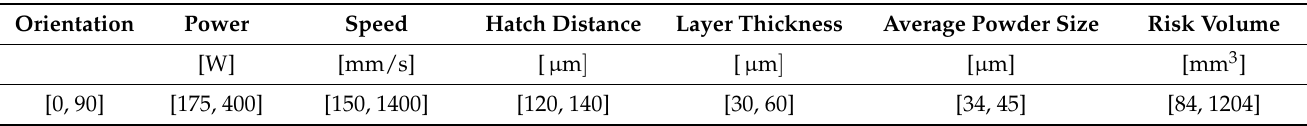
Table 2. Range of process parameters for the datasets on Ti6Al4V considered for the validation of the developed ML algorithms.